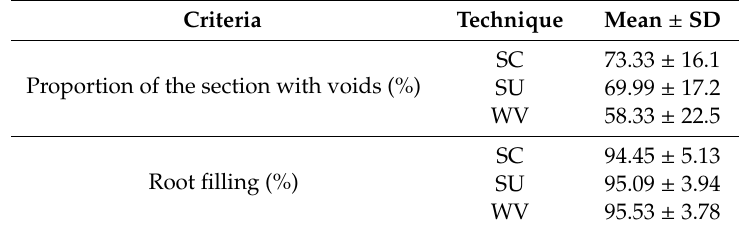
Table 2. Mean percentage and standard deviation (SD) of sections with voids in two-dimensional slices and the volume percentage of the voids in three-dimensional images.